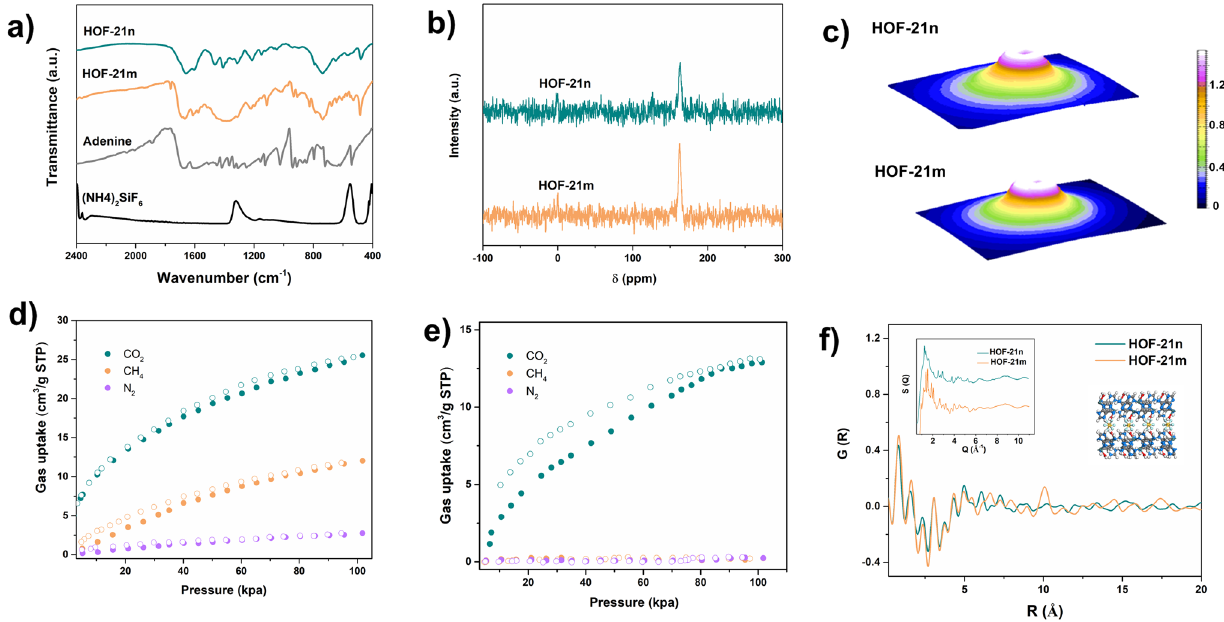
Fig. 2 a FTIR spectrum of ade, (NH 4 ) 2 SiF 6 , HOF-21n and HOF-21m. b Solid-state NMR of HOF-21n and HOF-21m. c 3D-images of X-ray total scattering for HOF-21n and HOF-21m. d Gas uptakes of HOF-21m at 298 K. e Gas uptakes of HOF-21n at 298 K. f Pair function analysis of HOF-21n and HOF-21m, calculated from the data of 2c . The inset is structural factor of HOF-21n and